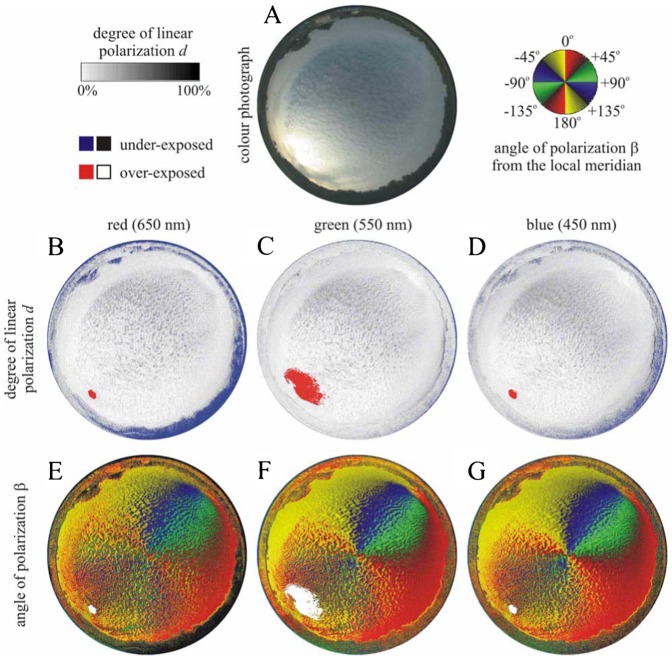
As Fig. 4 for the strongly cloudy sky no. 324